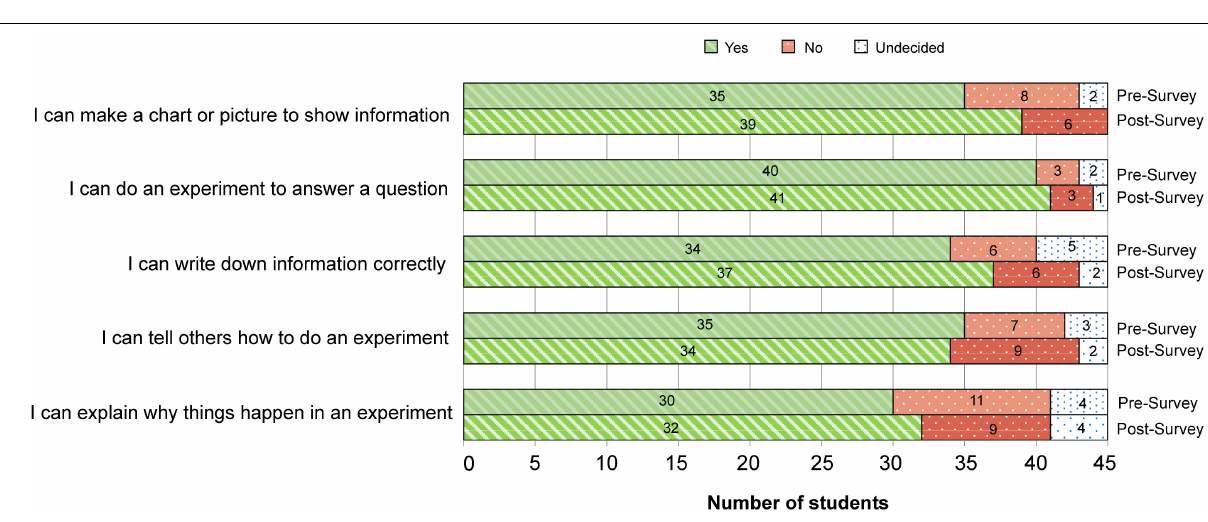
FIGURE 8 | Science process skills inventory statements. Results from the questions that assess experimentation adapted from Arnold and Bourdeau (2009). Demonstrates number of students that selected each answer. Pre and post survey answers are stacked directly, respectively, on top of each other for each question. Cronbach alpha 0.659 and 0.4 for pre and post survey,